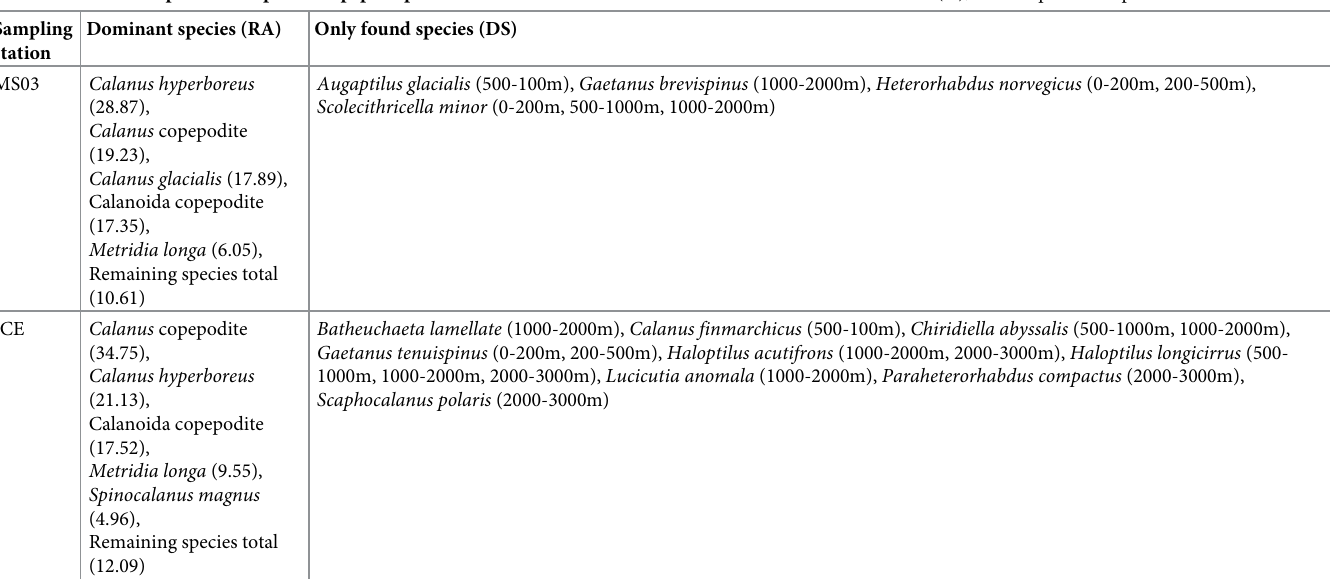
Table 4. Dominant species and specific copepod species found at stations MS03 and ICE. RA is relative abundance (%), DS is depth of samples. Sampling